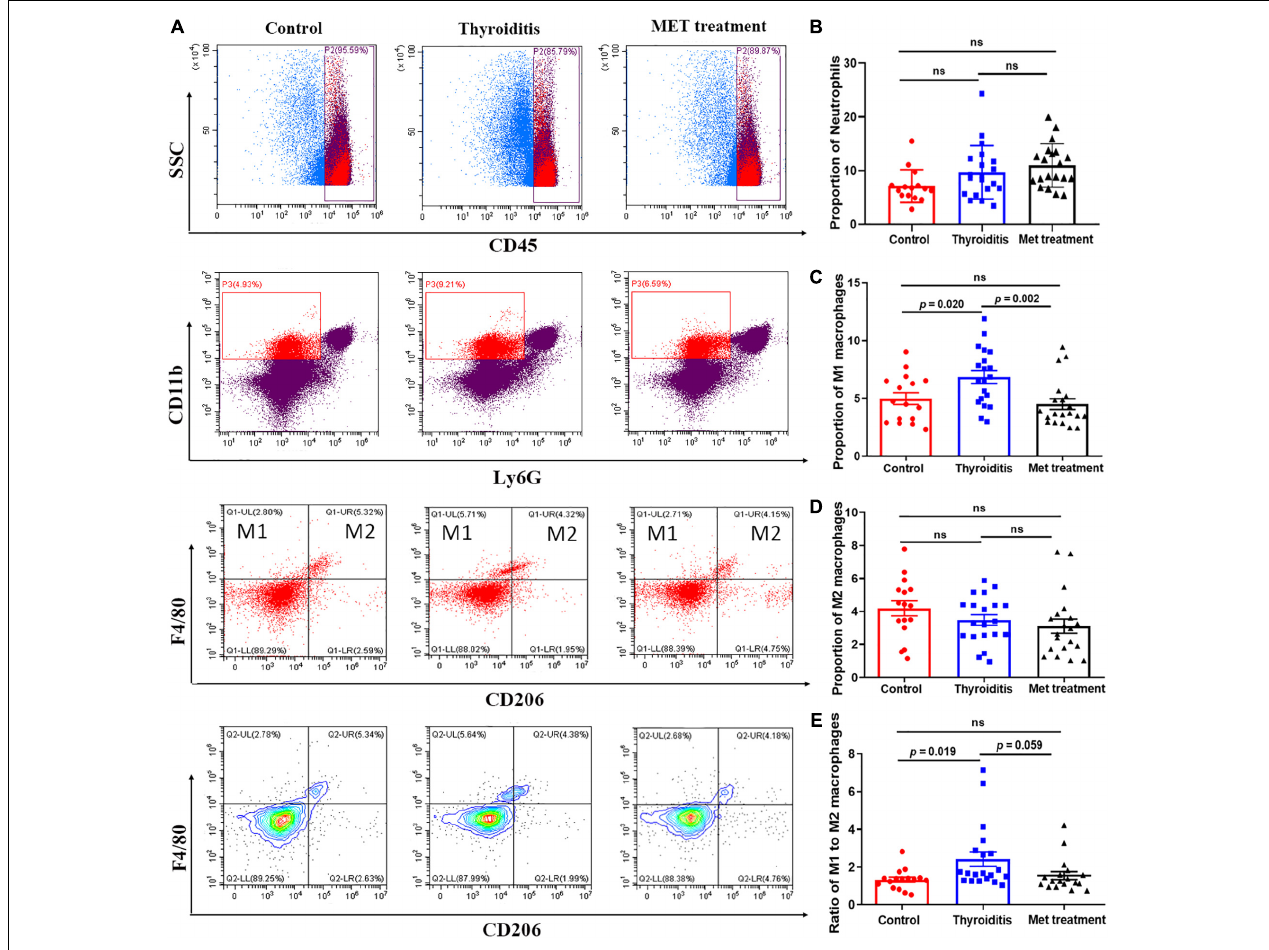
FIGURE 5 | Flow cytometry and statistics of mouse spleen neutrophils and macrophages; (A) Flow cytometry diagram, (B) Proportion of neutrophils, (C) Proportion of M1 macrophages, (D) Proportion of M2 macrophages, (E) Ratio of M1–M2 macrophages.